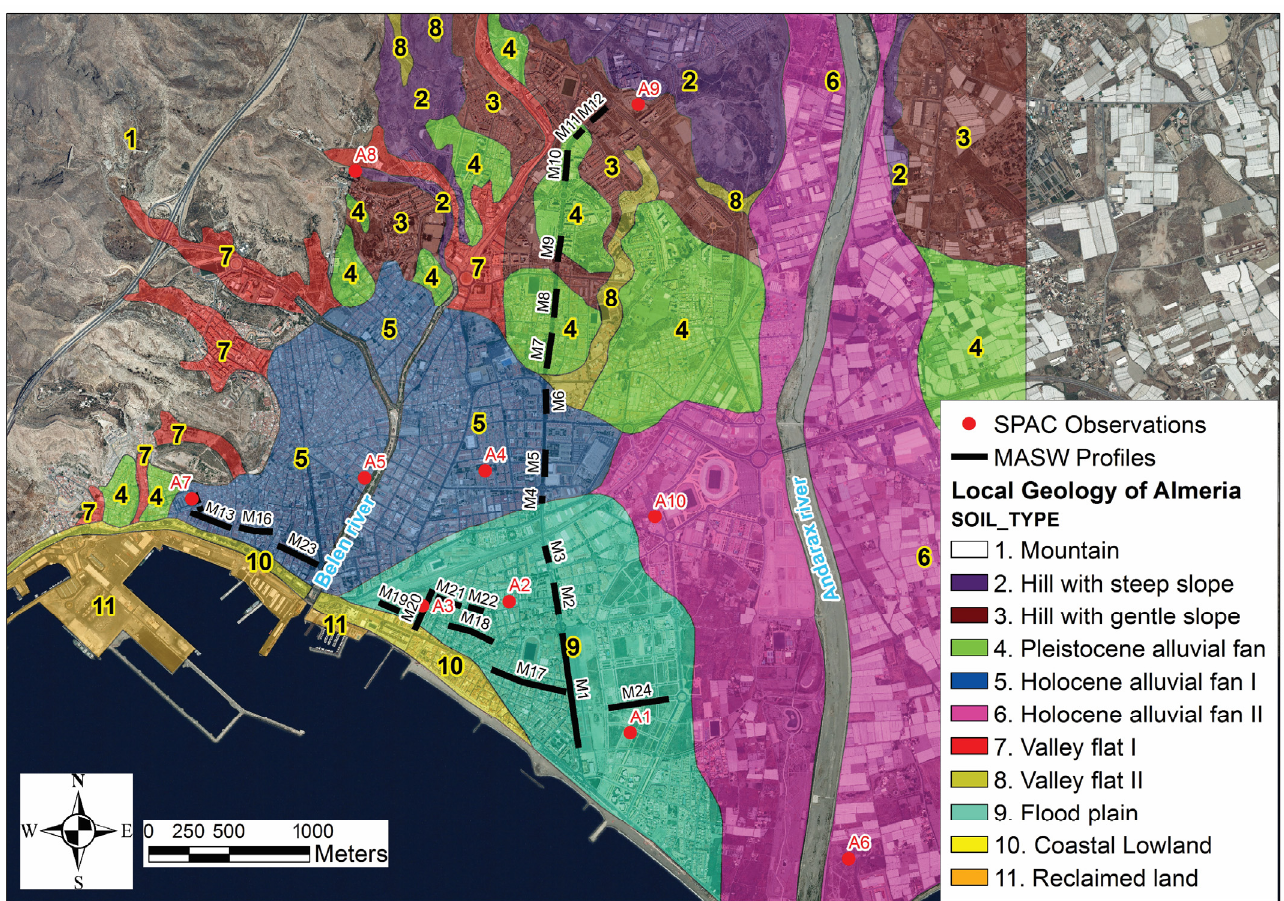
Figure 2. Local geology map of Almeria City providing the location of SPAC arrays (labels from A1 to A10) and MASW profiles (labels from M1 to M24).